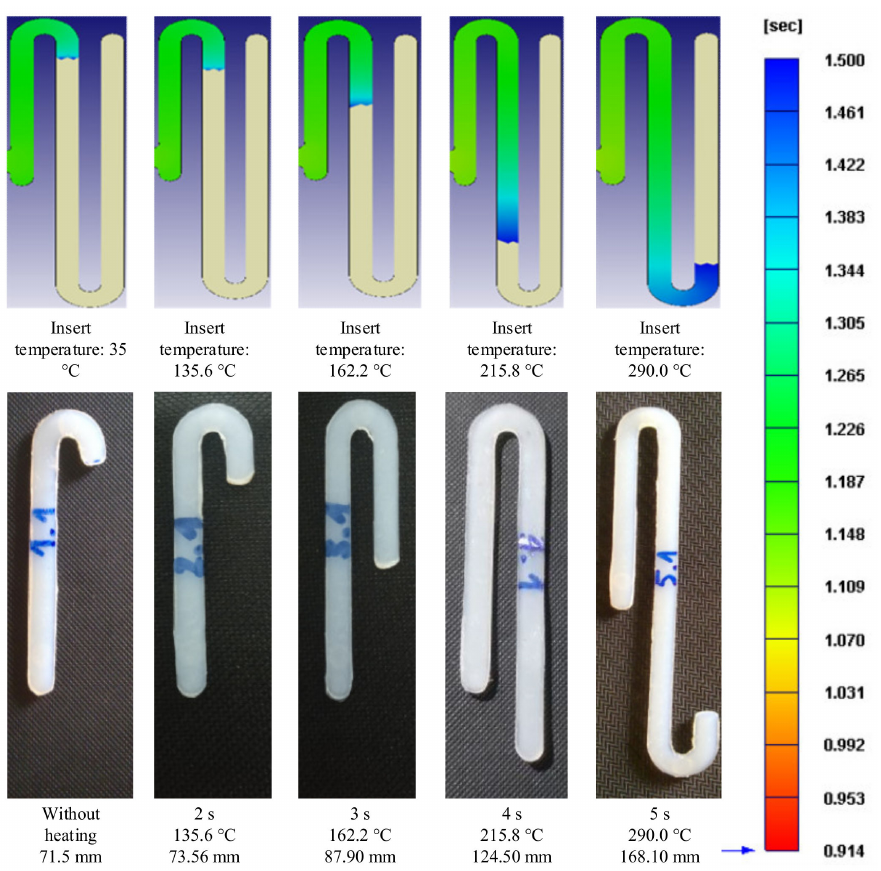
Figure 14. The simulation and experiment of melt flow length model after molding with Ex-IH under different heating times.